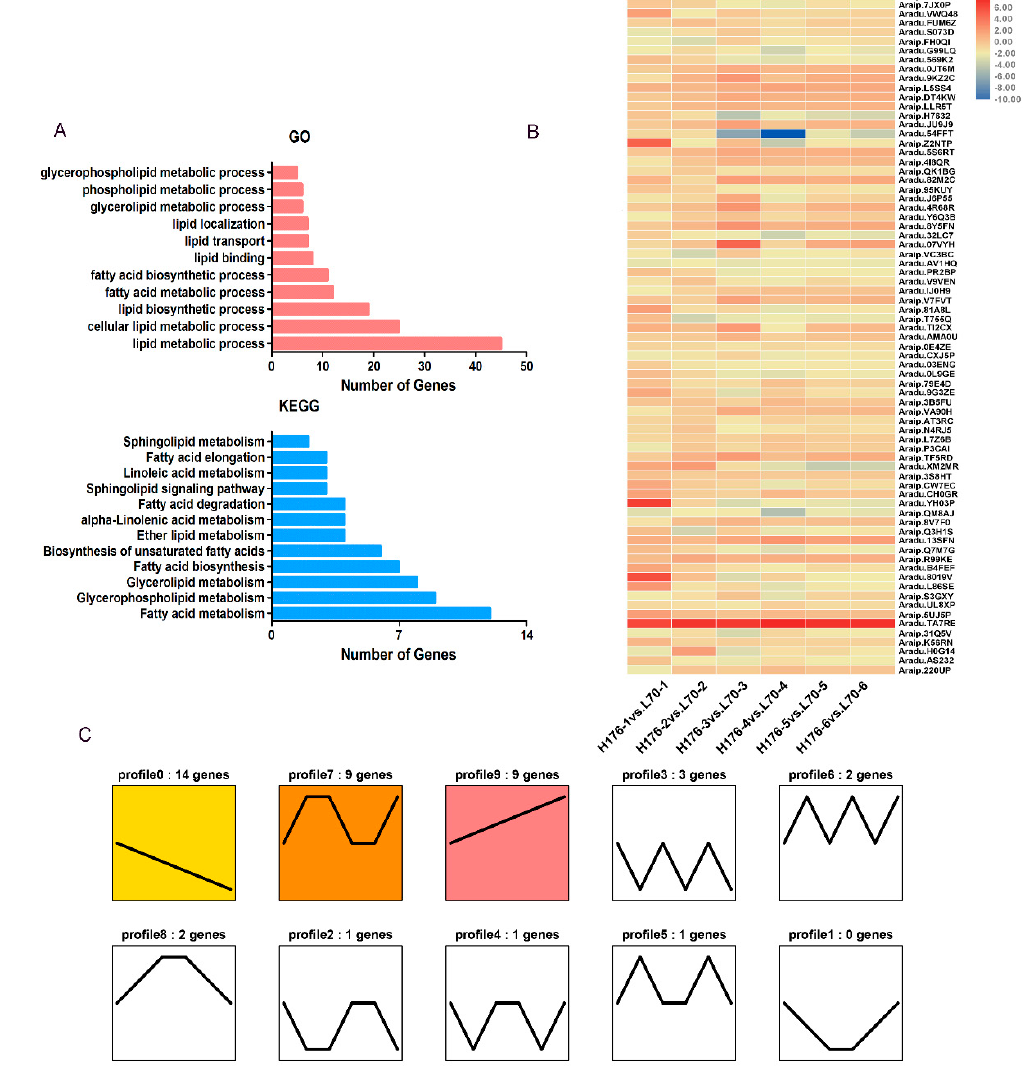
Figure 3. Expression analysis of lipid DEGs among six developmental stages in h176 vs. L70. ( A ) GO (gene ontology) and KEGG (kyoto encyclopedia of genes and genomes) enrichment analysis of total 74 lipid DEGs. ( B ) Heatmap showing the relative expression of total lipid DEGs at each stage in L70 and H176. ( C ) Trend analysis of lipid DEG expression (10 trends). Colored block trend: significant enrichment trend ( p < 0.05). Without color trend: the enrichment of significant trends.